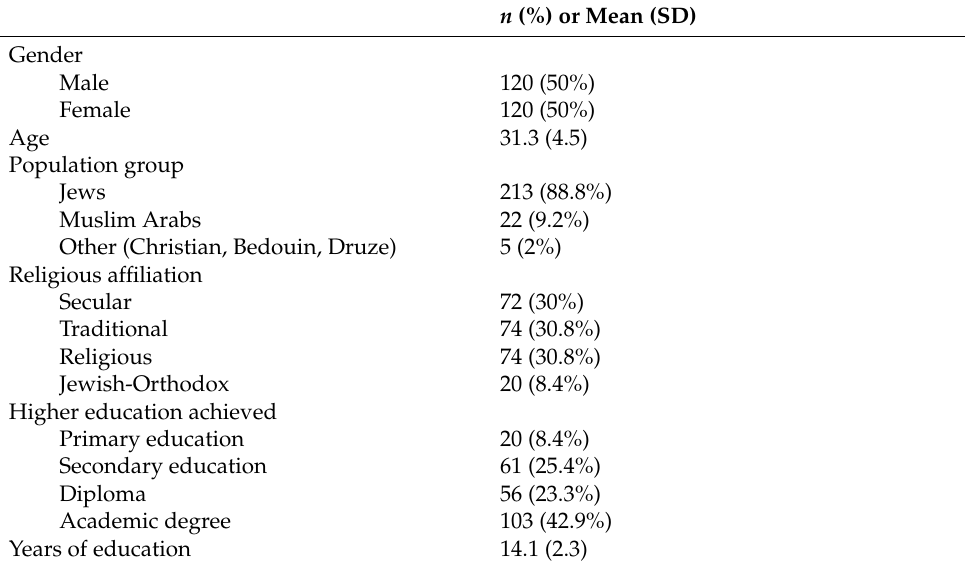
Table 1. Socio-demographic characteristics of the study population ( n = 240).